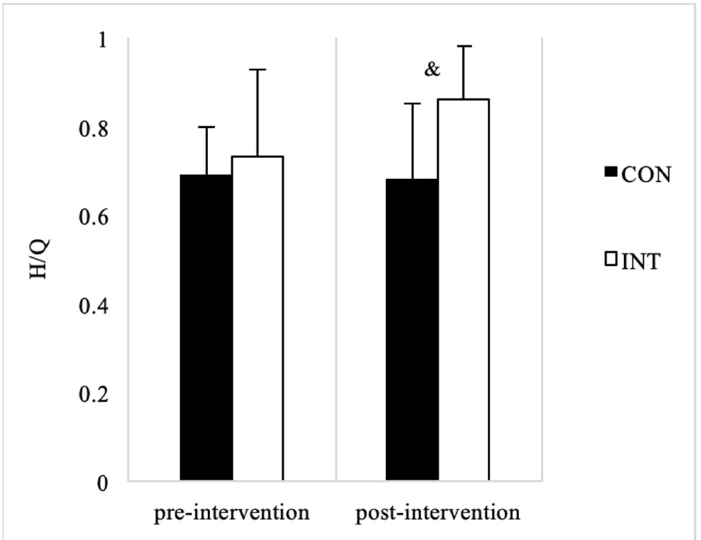
Figure 1. Knee Strength Ratio (H/Q). Note: Comparison between the control group and the intervention group during the same period: & = p < 0.05. Table 3. Changes in running